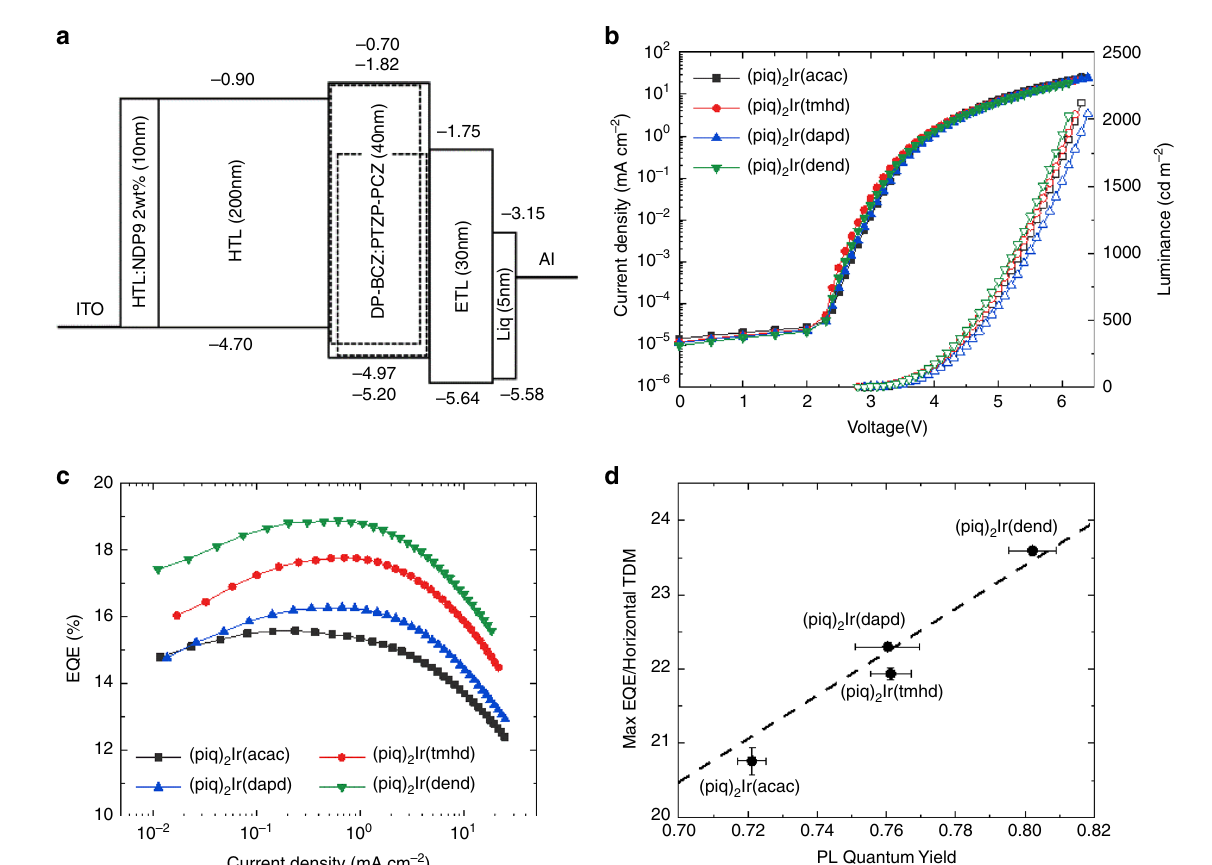
Fig. 5 Device structure and OLED characteristics of Ir(III) complexes. a Schematic diagram of the OLED device structure and the energy levels of each layer. b The current density – voltage – luminance curves of OLEDs. c EQEs as a function of the current density. d Maximum EQE normalized by horizontal transition dipole moment according to the PL quantum yield. Error bar for PL quantum yield indicates standard error of the mean (sample standard deviation divided by the square root of 6 measurements) and error bar for y -axis is standard error of the mean for 4 measurements.